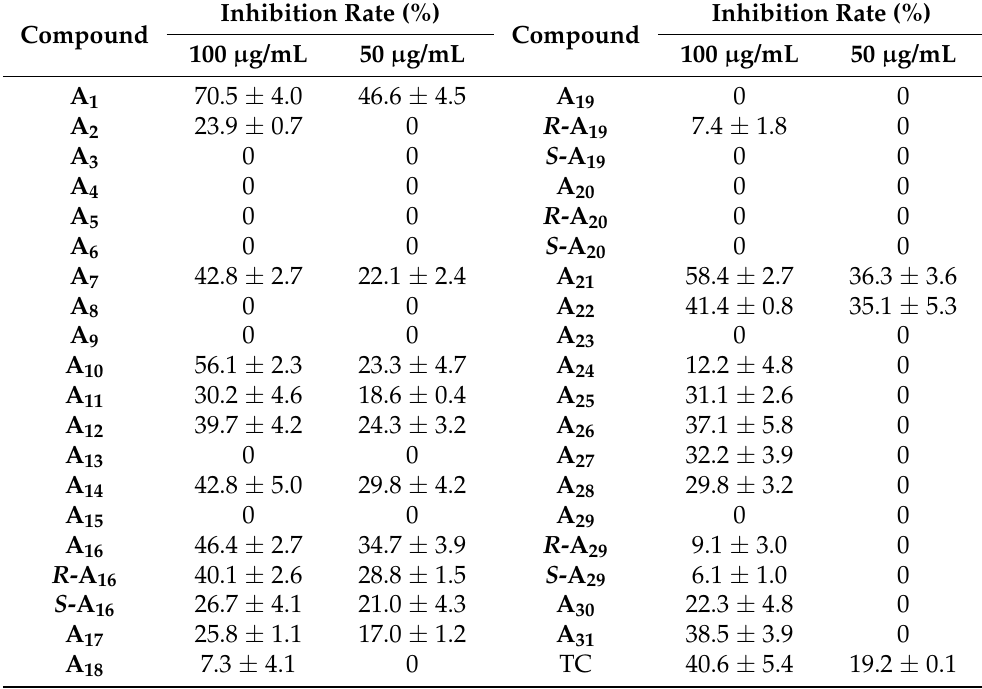
Table 5. In vitro antibacterial activities of target compounds against plant pathogen R. s .